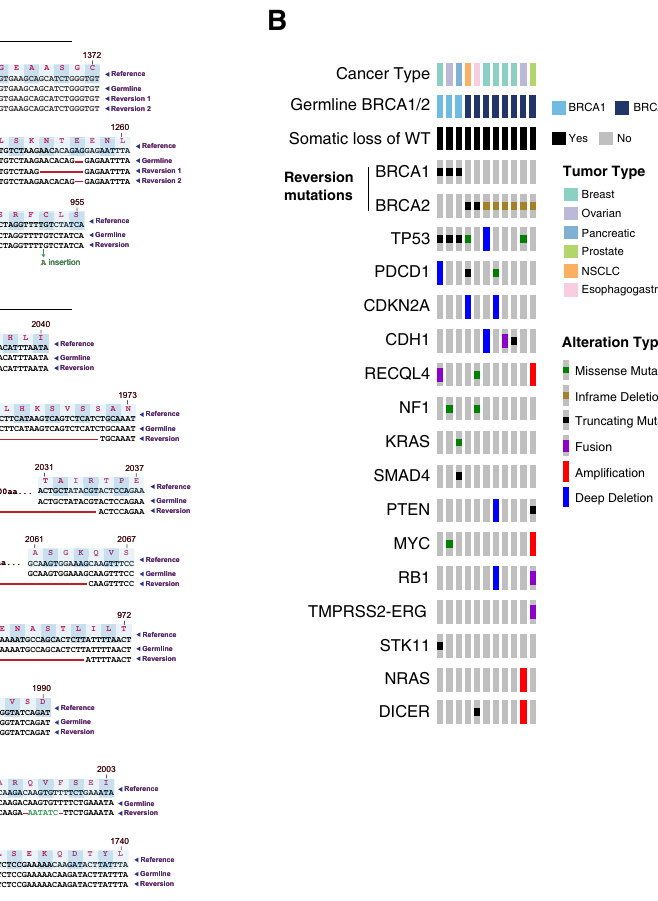
Fig. 2 | Reversionmutationsingermline BRCA1/2 carriers.A The nucleotide and protein coding sequence for the germline and somatic reversion mutations are shown with respect to the reference genome for patients with BRCA1 ( n =3) and